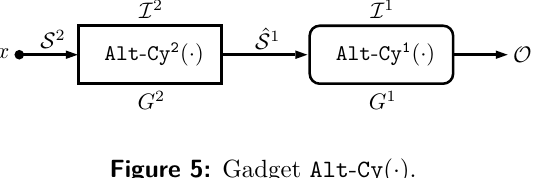
Figure 5: Gadget Alt - Cy ( ·